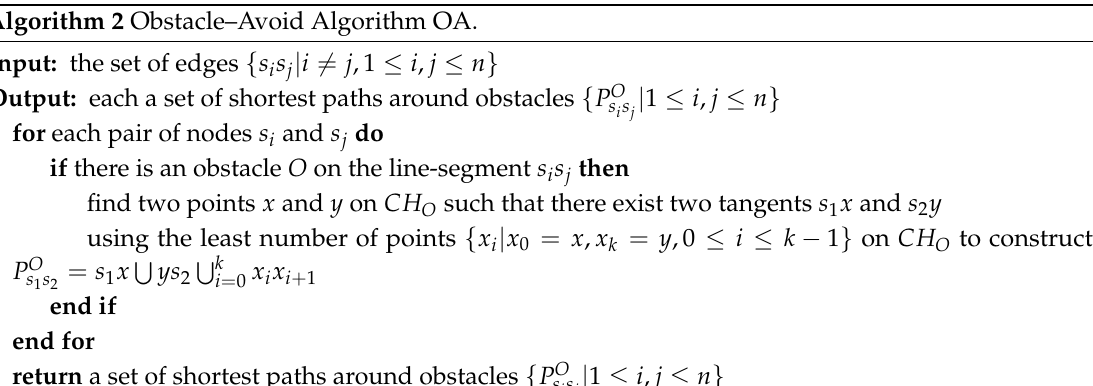
Algorithm 2 Obstacle–Avoid Algorithm